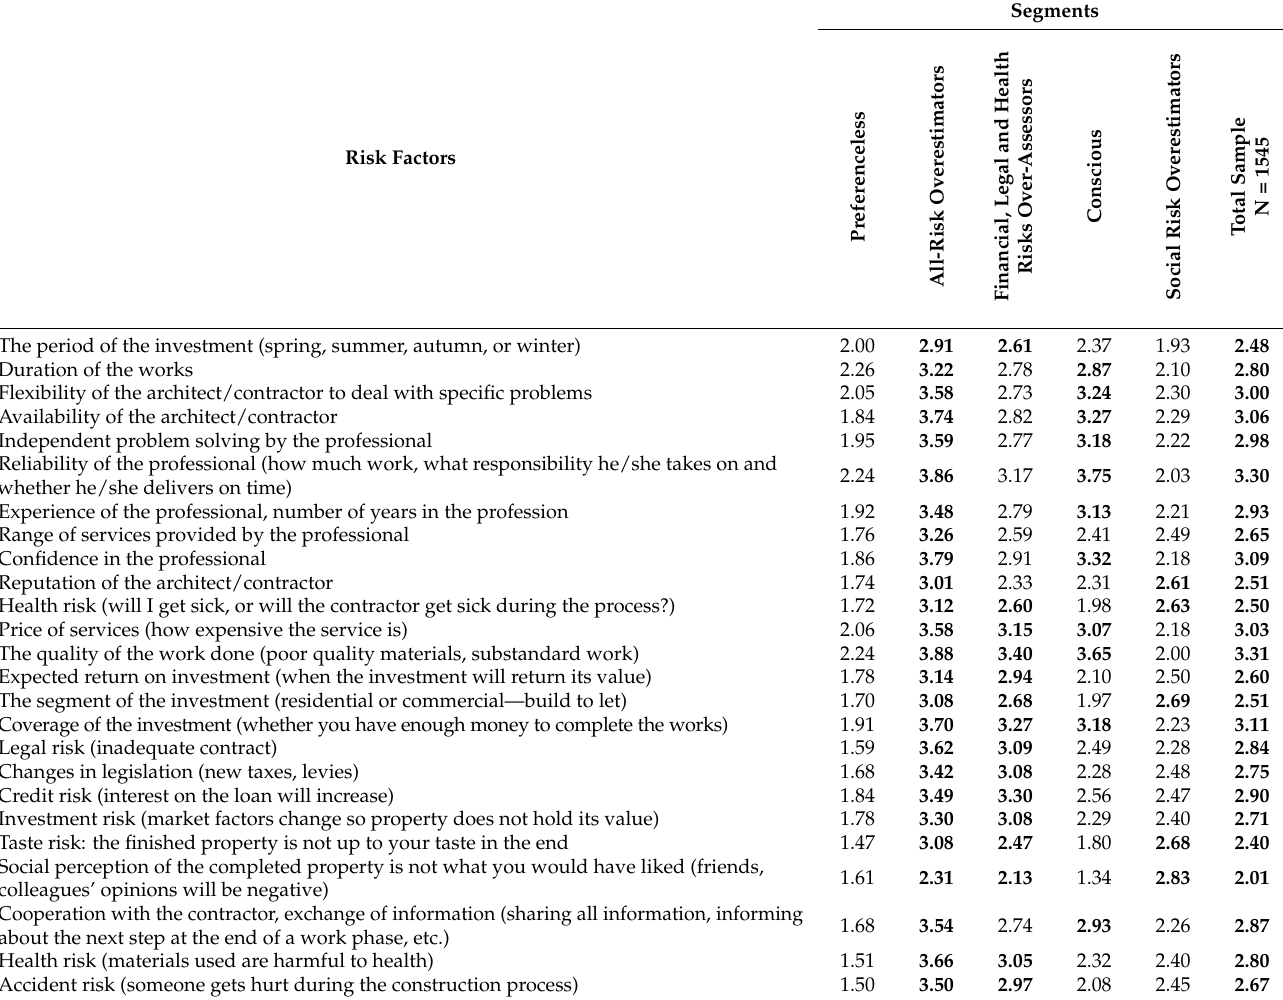
Table 7. Investor segments by perceived risk factors.